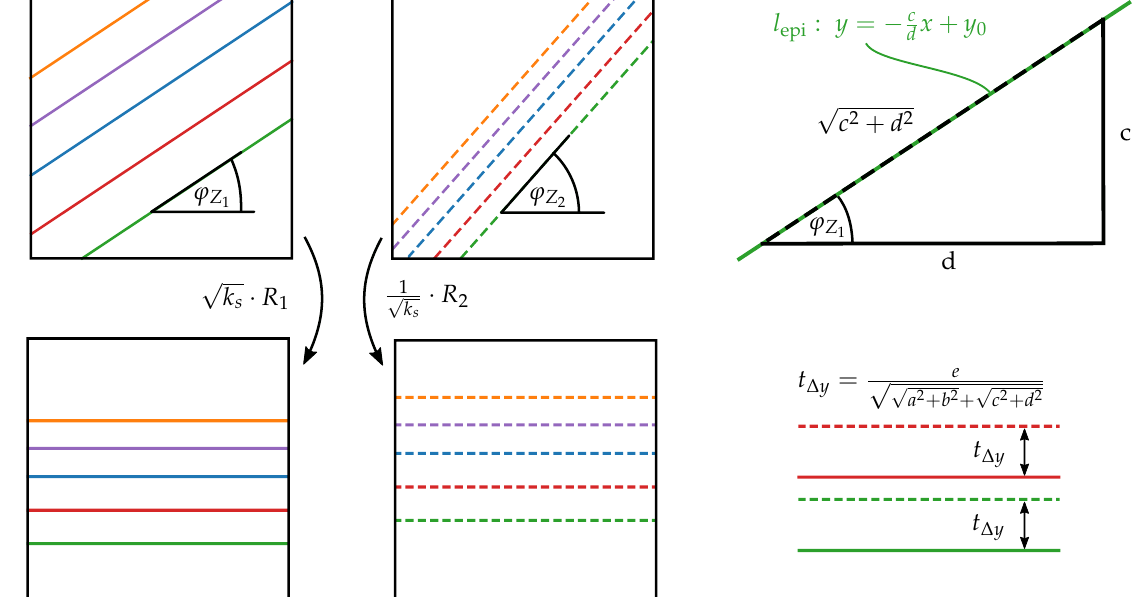
Figure 6. Unrectified epipolar lines for an affine projection with the slope angles ϕ Z the rotations R 1 , R 2 and the scaling adjustment results in horizontal and evenly spaced epipolar lines. Finally, the translational offset t ∆ y can be compensated. In the top right, the definition of an epipolar line l epi is given and the triangle that allows to define the rotation matrices of Equation